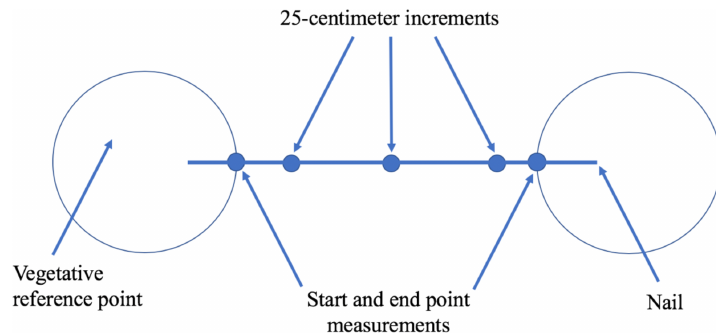
Figure A3. A schematic of the height measurements made along a transect between two vegetative reference points.